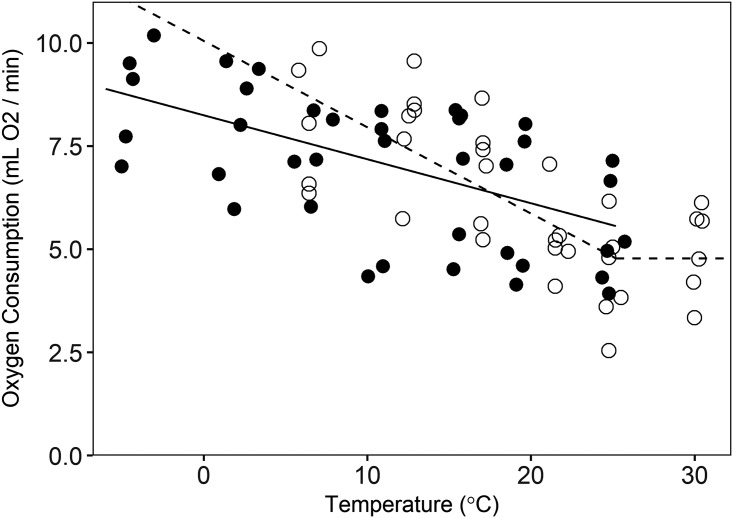
Oxygen consumption by pygmy rabbits (Brachylagus idahoensis) at different temperatures during summer (open circles, dashed line) and winter (filled circles, solid line).The line segments at temperatures below the breakpoint illustrate the relationship between oxygen consumption and temperature below the lower critical temperature, whereas the line segment above the breakpoint shows minimal resting metabolic rate in the thermoneutral zone of summer-acclimatized animals.